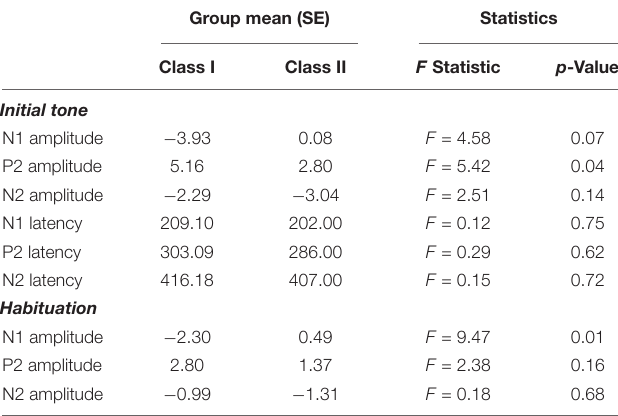
TABLE 3 | Analysis of PMS genetic classes and electrophysiological measures.